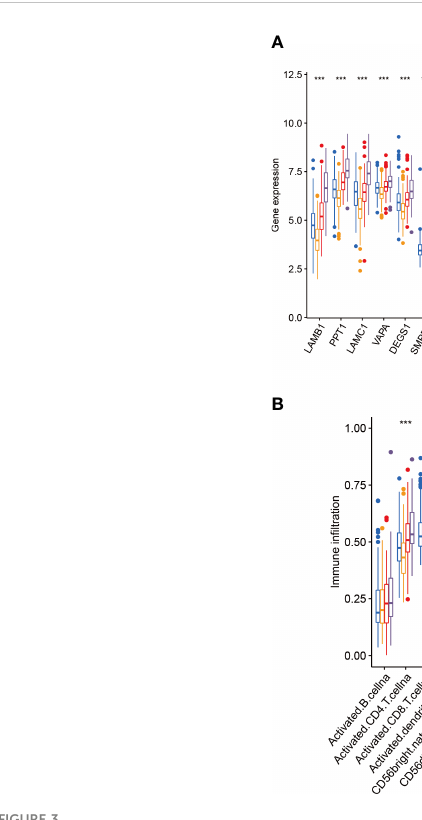
FIGURE 3 Patterns of immune in fi ltration and gene expression among four SPGs-based clusters. (A) SPGs expression of four subtypes. (B) Immune in fi ltration patterns of four subtypes. (Wilcox test, * P < 0.05, ** P < 0.01, *** P <